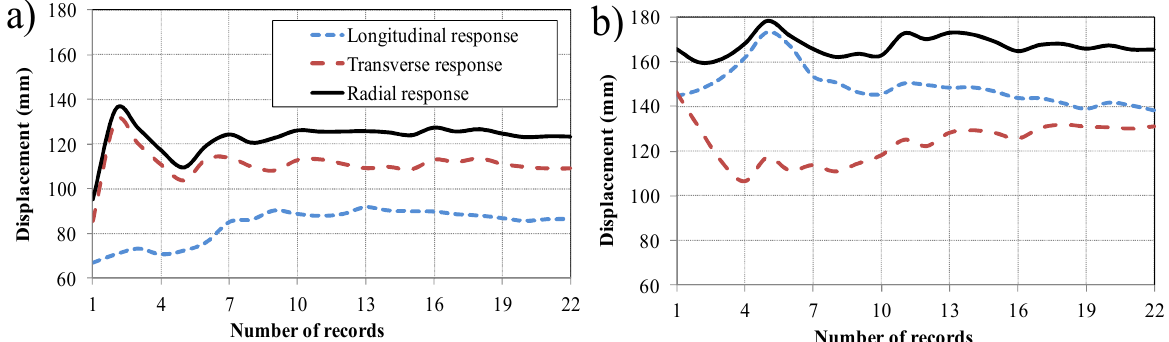
Figure 5. Influence of the number of records on the predictions of the mean displacement of column C2 for: ( a ) regular bridge and ( b ) irregular